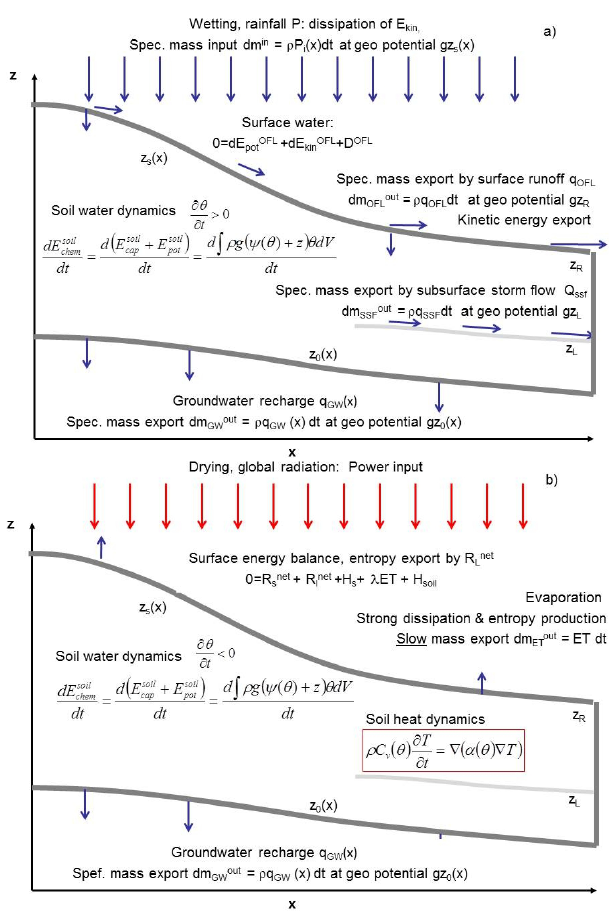
Fig. 1. Free energy dynamics of a hillslope during rainfall-/mass- flow-driven conditions; (a) potential energy input from rainfall (Eq. 5), kinetic energy export by means of overland flow (Eq. 6), changes in free energy of soil water arising from changes in soil wa- ter content (capillary binding energy and potential energy; compare Eqs. 2 and 7) as well as export of water mass at different poten- tial energy levels (please refer to Eq. 7). Free energy dynamics of a hillslope during radiation-driven conditions; (b) components of the surface energy balance (i.e. net radiation, sensible and latent heat fluxes) as well as soil heat dynamics triggered by the soil heat flux. Note that the soil heat budget is linked to soil water dynamics as the volumetric heat capacity C v (θ) and thermal conductivity α(θ) depend on the actual soil water content θ